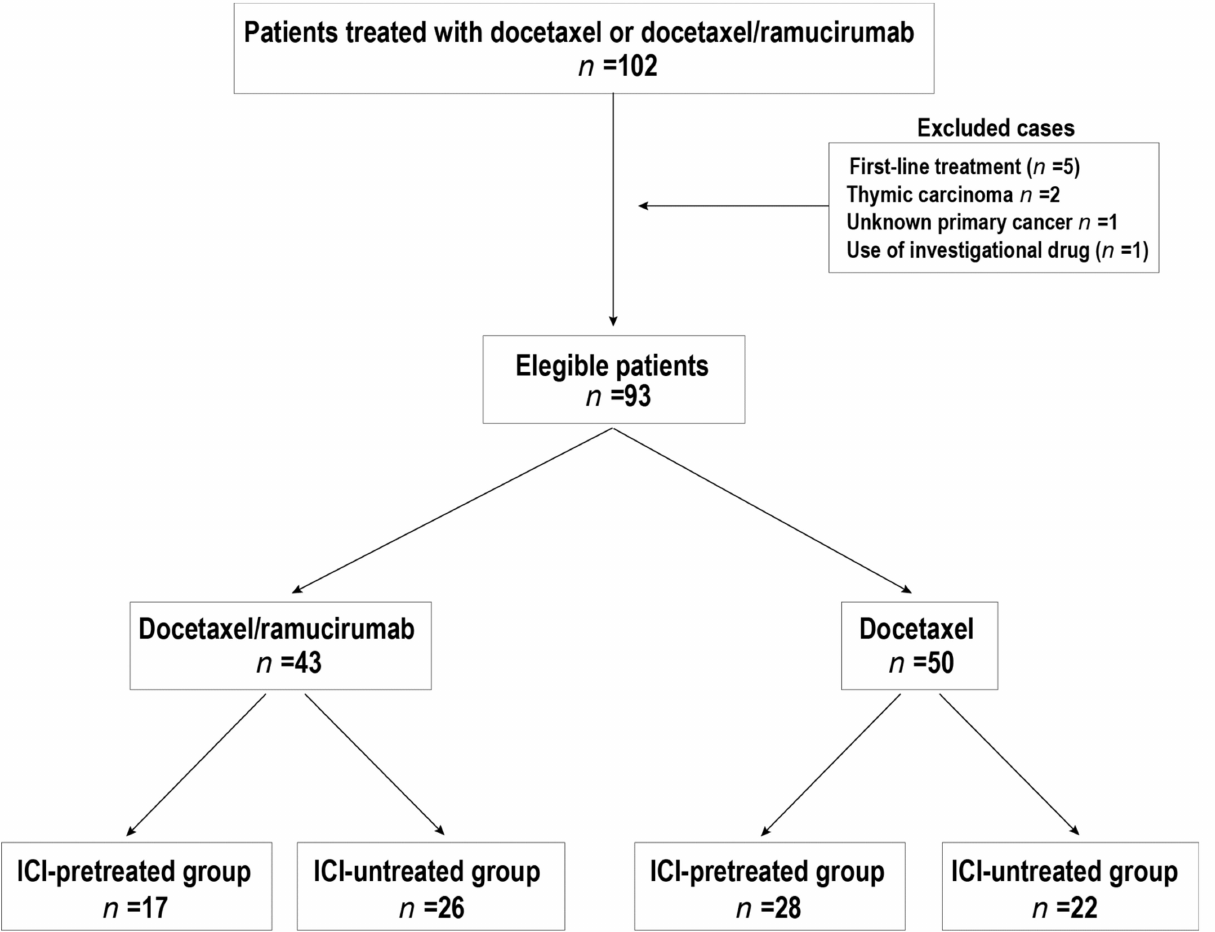
Figure 1. Study flow chart. The patients were divided into the DTX and DTX/RAM treatment groups. DTX: docetaxel. ICI: Immune checkpoint inhibitor. RAM